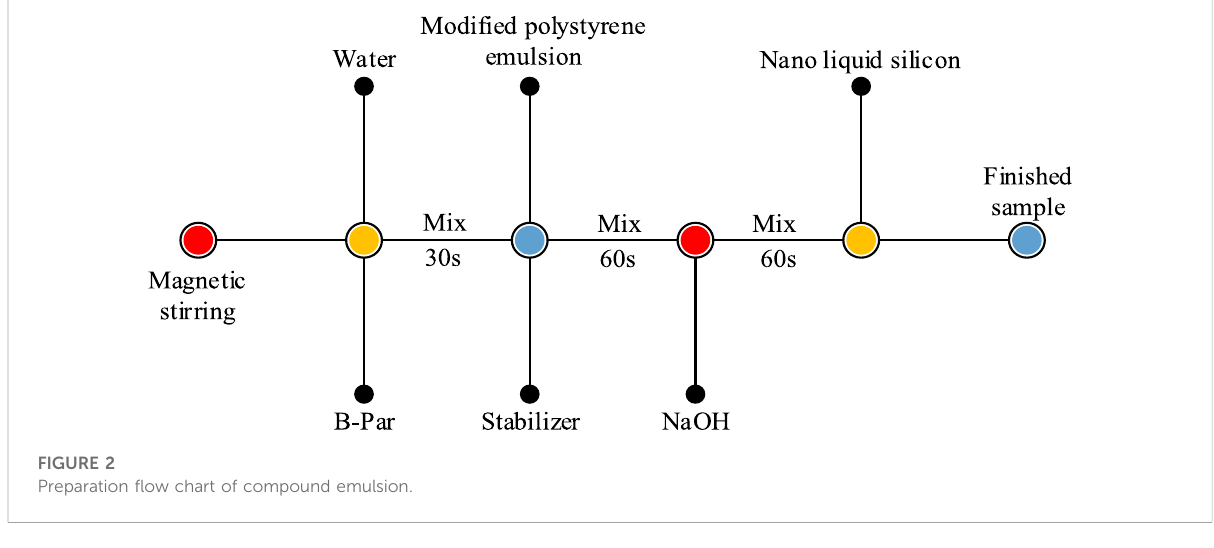
FIGURE 2 Preparation fl ow chart of compound emulsion.